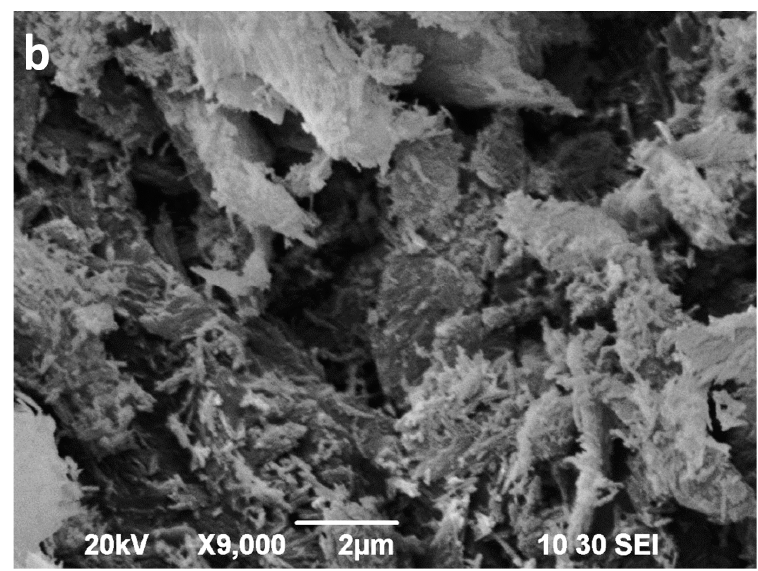
Figure 11 . SEM images of the sepiolite Sp2 ( a ) and sepiolite Sp2 after 16 min of microwave-assisted acid treatment ( b ).